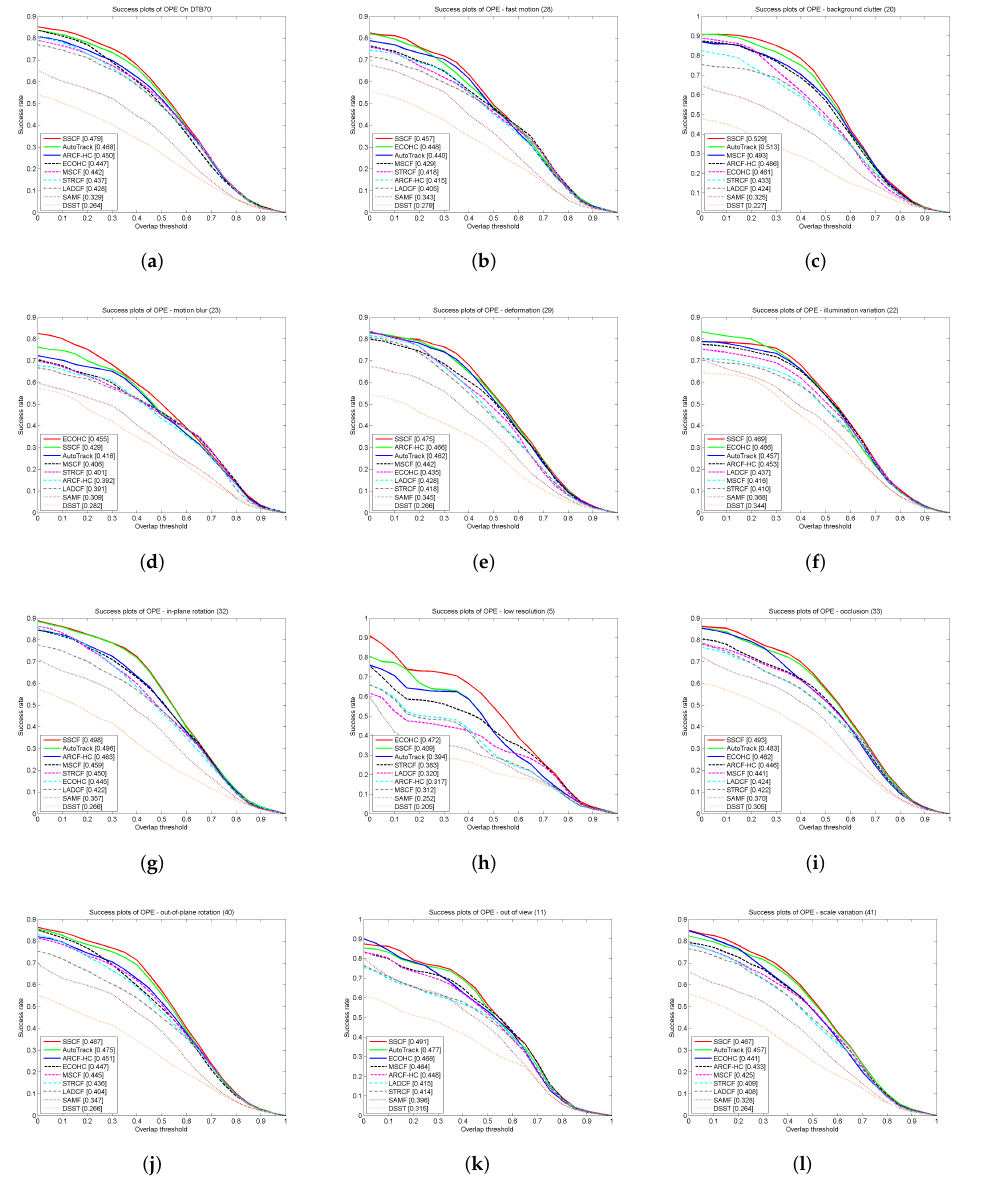
Figure 4. Success plots of the proposed SSCF and the other trackers on the DTB70 database. ( a ) Overall performance; ( b – l ) success plots on the 11 different